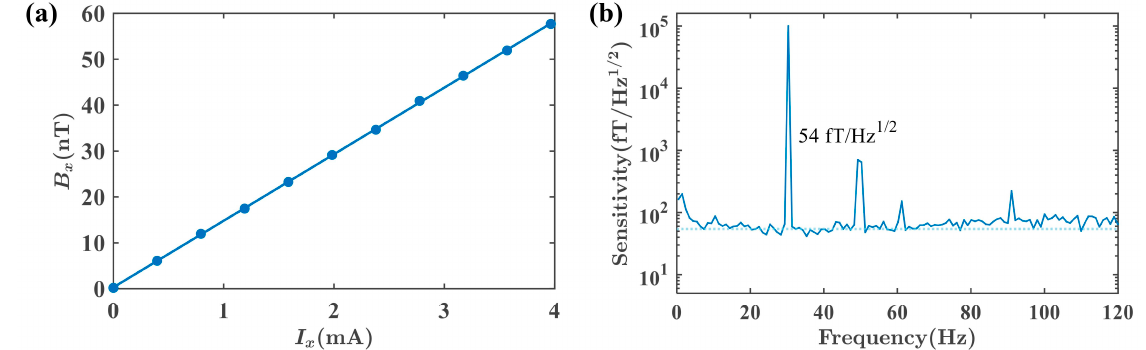
Figure 7. ( a ) The measurement of magnetic field generated by the same coil as that in subsection 4.3 with different coil currents, and using a flux-gate magnetometer, for comparison. ( b ) Sensitivity of the magnetic field measurement based on the first-order resonance of single-beam SERF magnetometers. The measurement sensitivity is evaluated by applying the calibration magnetic field signal to the magnetometer along with the modulated magnetic field. The sensitivity of magnetic field measurement is 54 fT/Hz 1/2 .